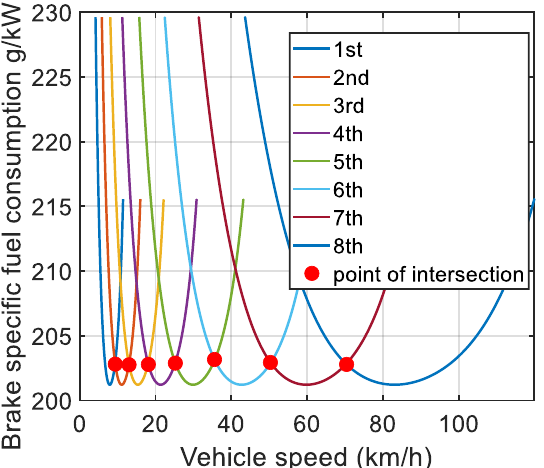
Figure 4. “Speed—Brake-specific fuel consumption” curve.